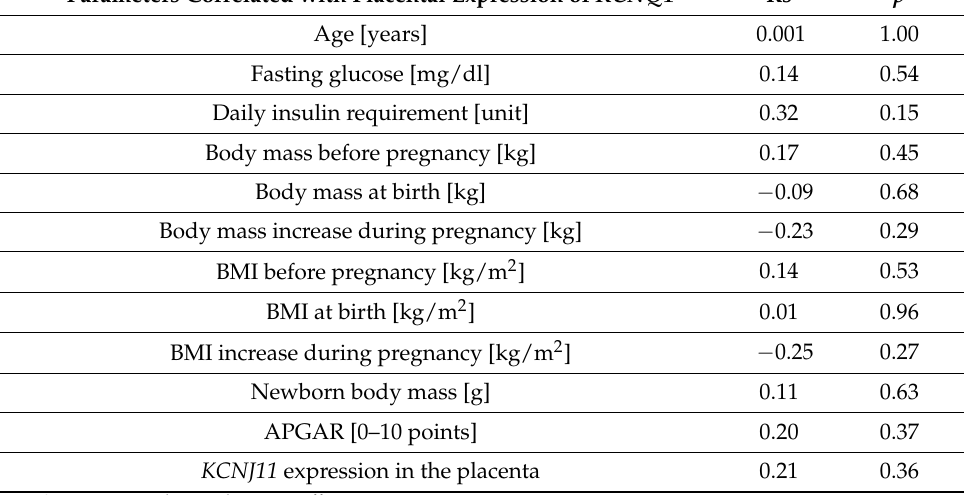
Table 9. Correlations between KCNQ1 expression in the placenta and clinical parameters in the GDM